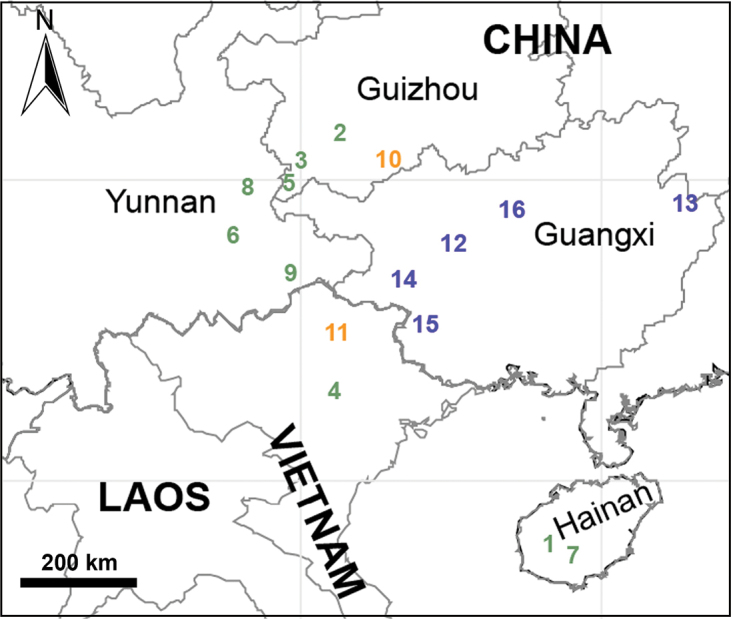
Distribution records of Pinelema spp., the feilong-group (green), the pacchanensis-group (orange), and the podiensis-group (blue): 1P.
bella comb. nov. 2P.
circularis comb. nov. 3P.
claviformis comb. nov. 4P.
damtaoensis5P.
feilong comb. nov. 6P.
huobaensis7P.
spina comb. nov. 8P.
vesiculata comb. nov. 9P.
yaosaensis10P.
daguaiwan sp. nov. 11P.
pacchanensis12P.
bifida comb. nov. 13P.
biyunensis comb. nov. 14P.
podiensis15P.
shiba sp. nov.16P.
zonaria comb. nov.